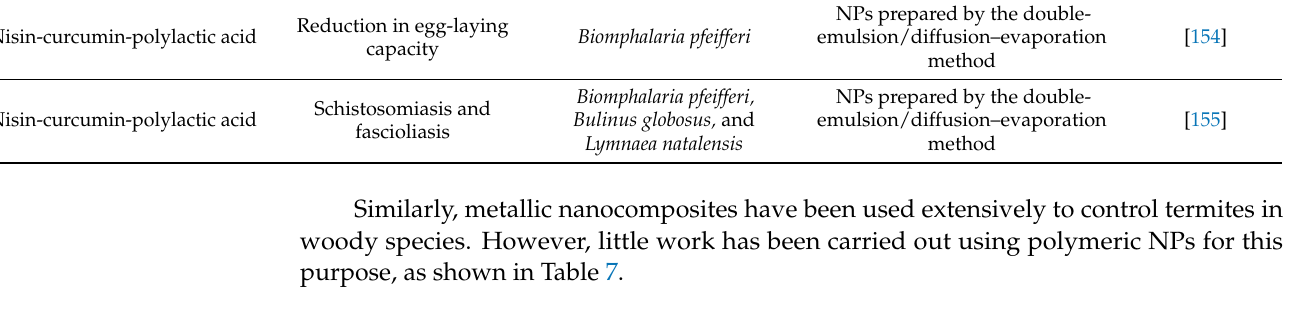
Table 7. Polymeric nanoparticles tested as carriers of